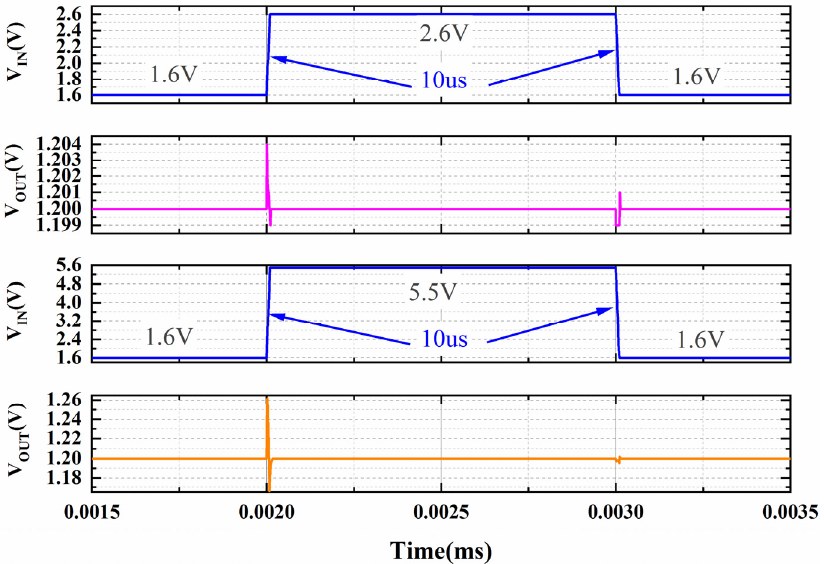
Figure 11. Simulated line transient response when input voltage change from 1.6 V to 5.5 V and 1.6 V to 5.5 V with a 10 μ s transition-edge time.